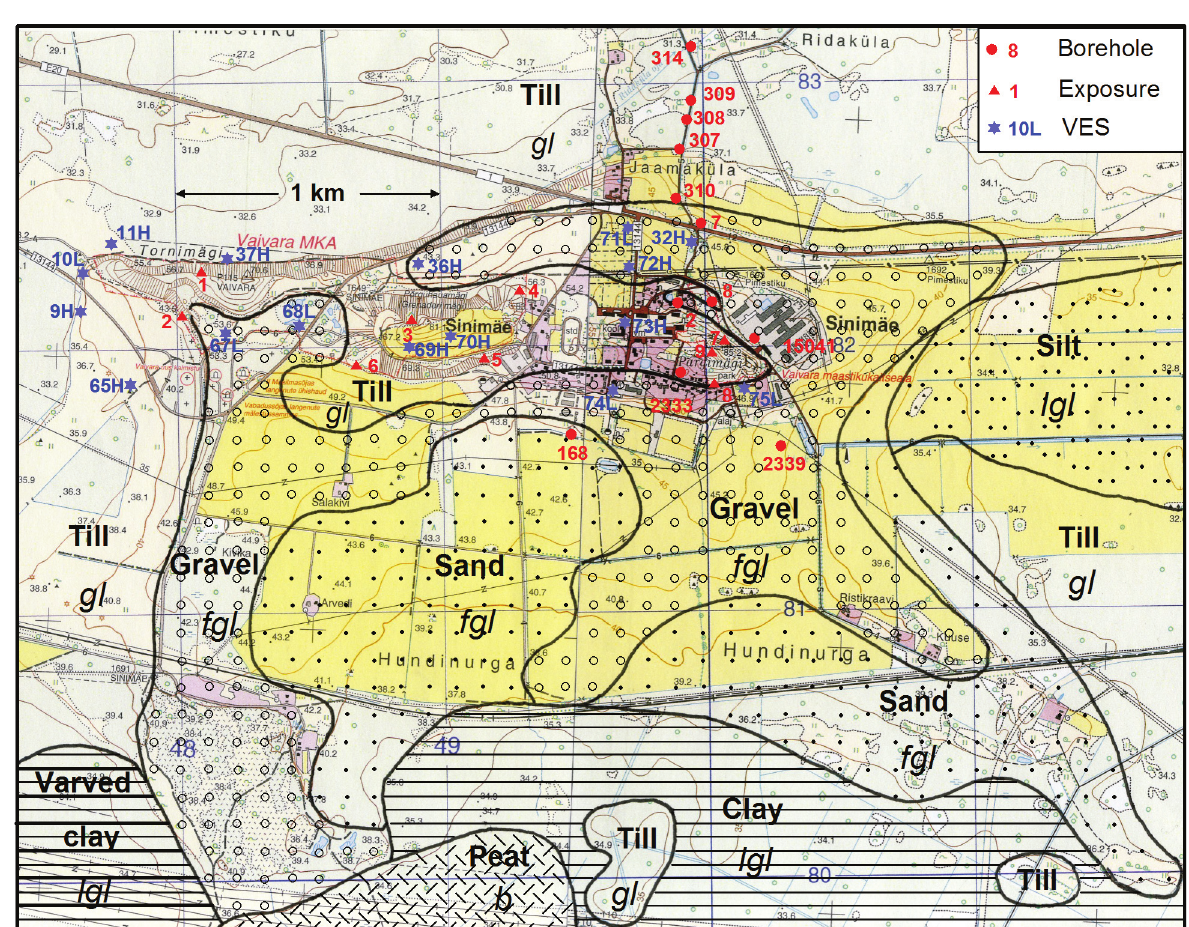
Fig. 5. The map of Quaternary deposits of the Vaivara Sinimäed and surroundings (modified after Miidel et al. 1969). Notation: gl , glacial; fgl , glaciofluvial; lgl , glaciolacustrine; b , bog; VES, vertical electrical sounding: H, high-resistivity curve; L, low- resistivity curve. Map topography is based on Estonian Basic Map 1 : 20 000, sheets Vaivara 65.81 (2002) and Auvere 65.82 (2007), Estonian Land Board, General Staff of the Estonian Defence